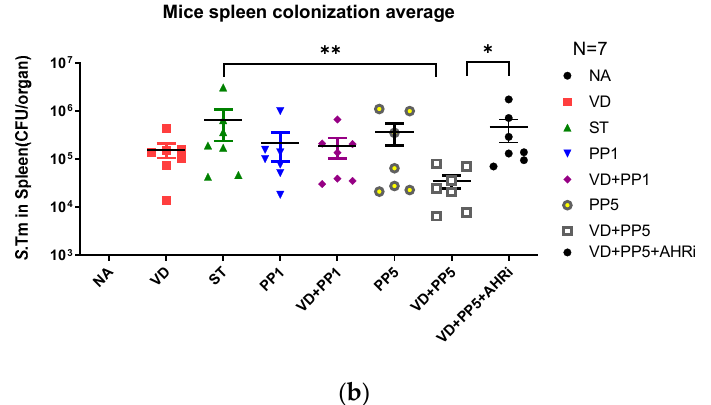
Figure 3. The involvement of AhR in the combined effects of PP and VD3 on attenuating systemic bacterial translocation of Salmonella colitis mice. Six–eight-week-old female C57BL/6 mice (Charles River, USA) were obtained from the animal facility of the Center for Cellular and Biomolecular Research, Kaohsiung, Taiwan. Mice were treated or infected as in Materials and Methods and divided into the following groups: Control (NA), ST ( S .Tm infected), VD (VD3 and S .Tm infected), PP1 or PP5 (1% or 5% propionate and S .Tm infected), VD + PP1 (combination of VD3 and 1%propionate plus S .Tm infected), VD + PP5 (combination of VD3 and 5% propionate plus S .Tm infected), VD + PP5 + AHRi (combination of VD3 and 5% propionate plus S .Tm infected and AhR inhibitor). Numbers of bacteria were counted from liver ( a ) and spleen ( b ) homogenates of different groups, as shown in Materials and Methods. The data shown are represented as the means ± the SEM of the bacterial load in the liver and spleen ( n = 7). (* p < 0.05, ** p < 0.01, *** p < 0.001).